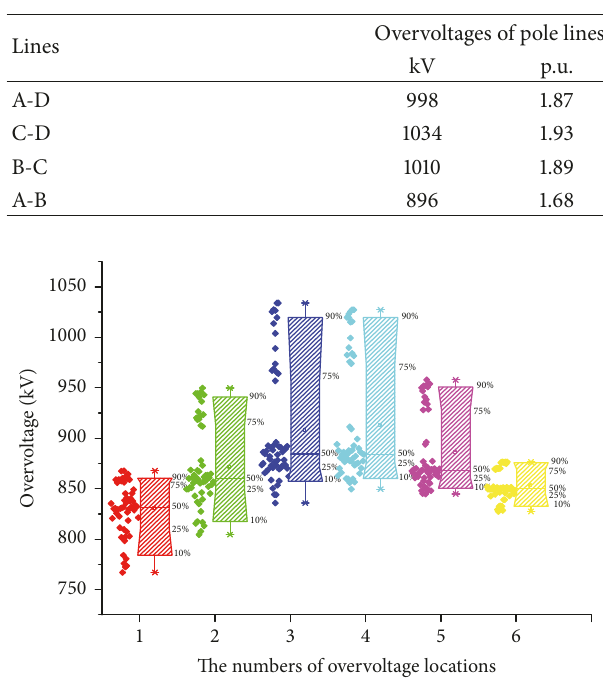
Figure 4: The overvoltage distribution and probability distribution of B-C line caused by A-D line fault under normal mode.